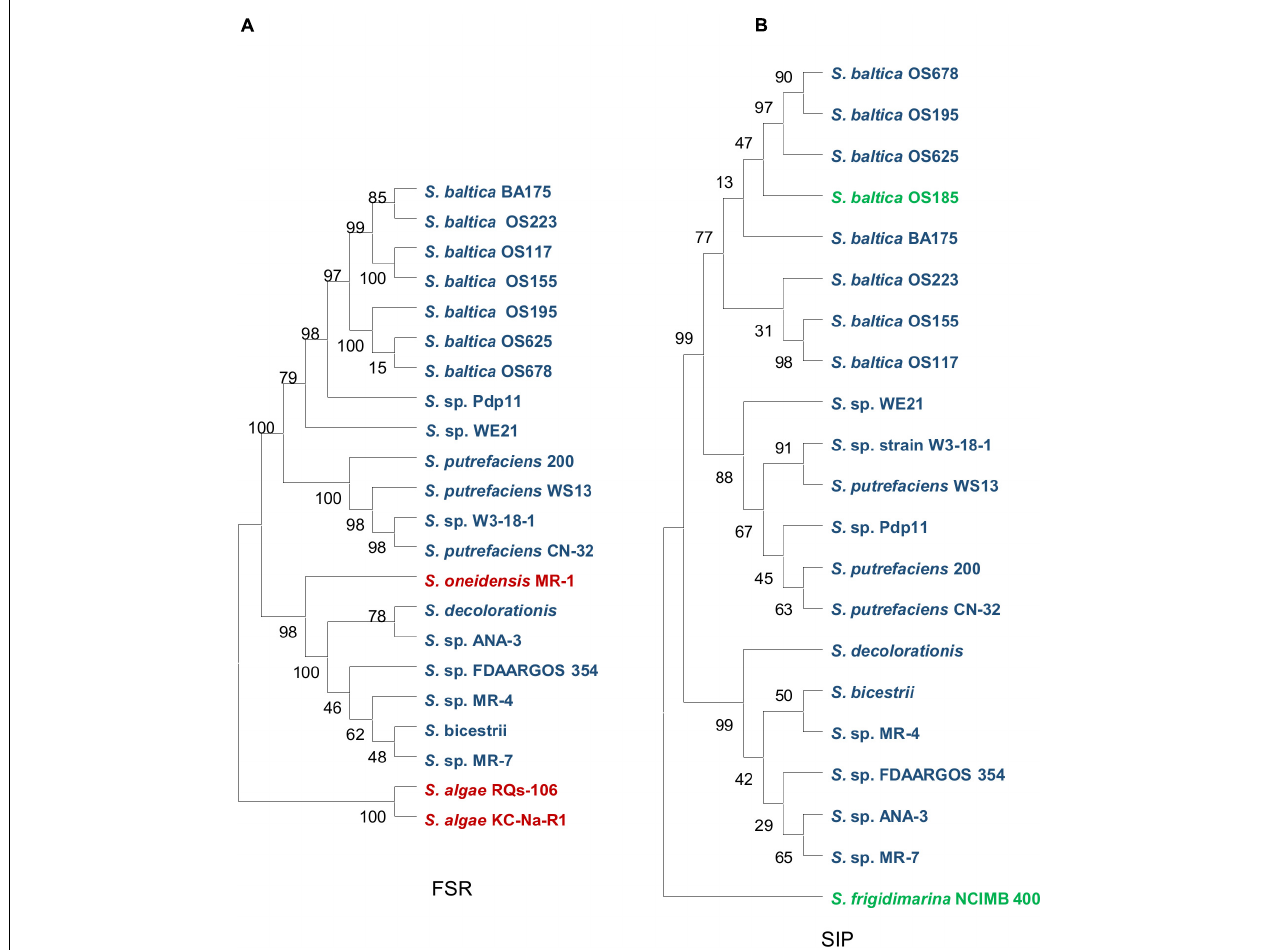
FIGURE 4 | Phylogenetic analysis of two ferricsiderophore reduction families in Shewanella spp. (A) The ferric-siderophore reductase (FSR) family. (B) The siderophore-interacting protein (SIP) family. Strains containing only FSR, only SIP, and both are in red, green, and blue, respectively.